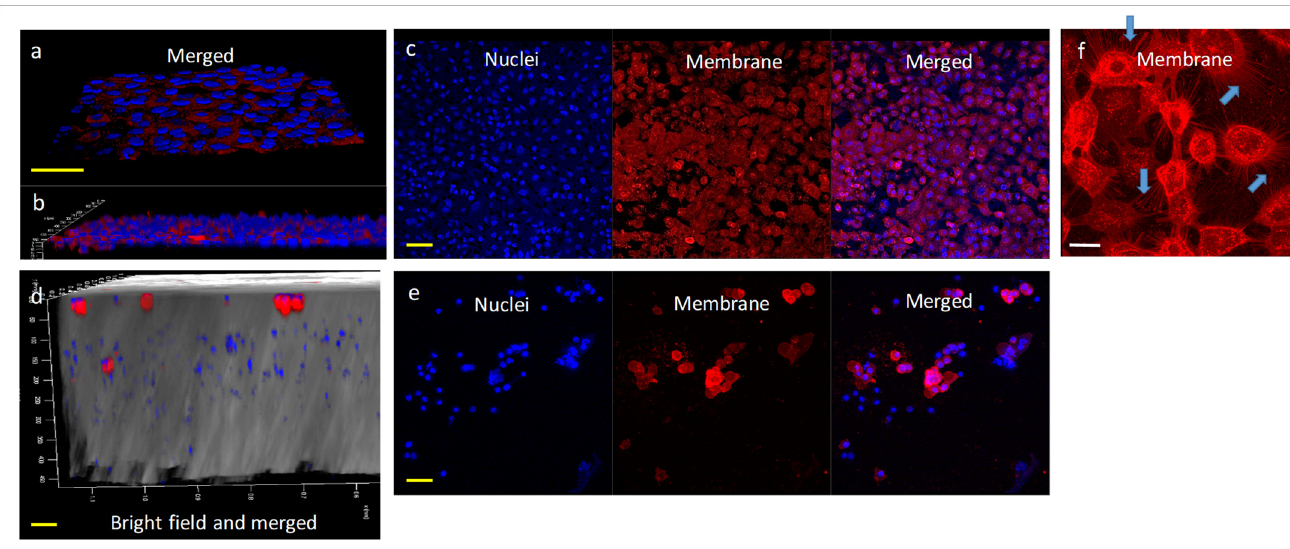
Figure 7. Confocal Images of 3D co-cultures. ( a , b ) 8-µm PET membrane seeded with A549 cells, angle ( a ) and side ( b ) views (Bar = 50 µm); ( c ) Monolayer of A549, top view (Bar = 50 µm); ( d ) ECM seeded with macrophages, side view (Bar = 50 µm); ( e ) Macrophages in ECM, top view (Bar = 50 µm). ( f ) Ciliated A549 cells on the membrane, arrows point to ciliate structures (Bar = 20 µm). Nuclei are stained by Hoechst (blue stain) and membrane by Dil perchlorate (red stain). Merged includes both nuclei and membrane staining—illustration of the 3D printed model in Supplementary Figure S2.